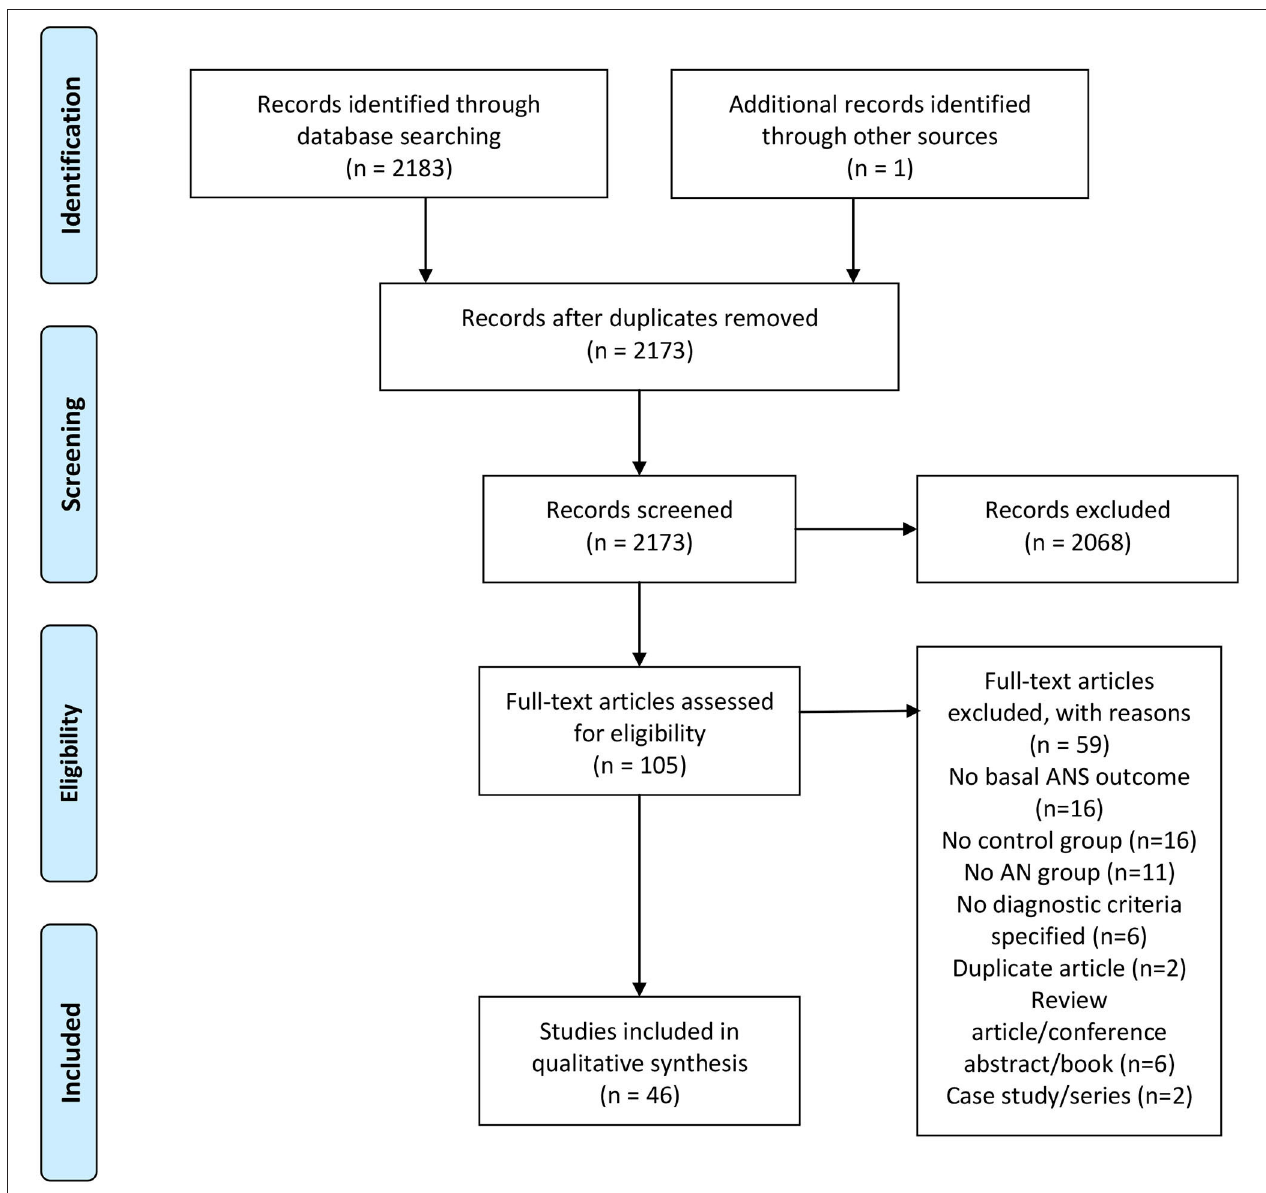
FIGURE 1 | PRISMA flowchart. From Moher et al.